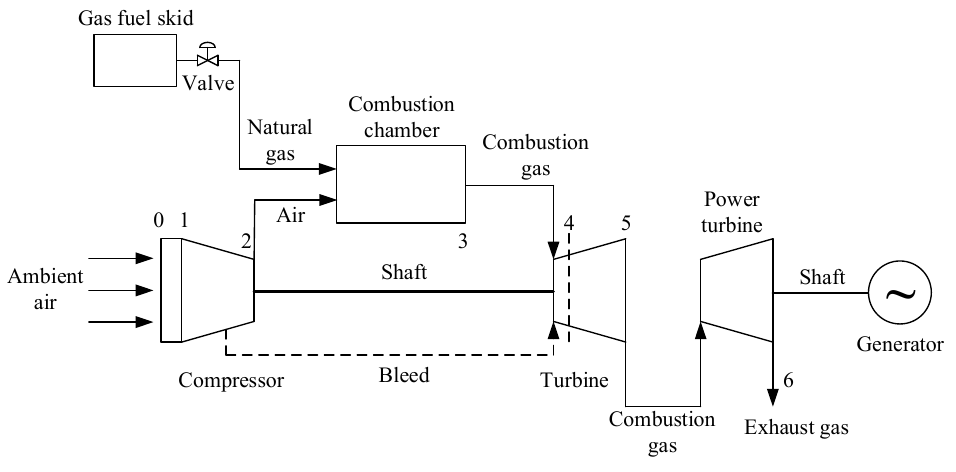
Figure 1. The structure of aero-derivative gas turbine.